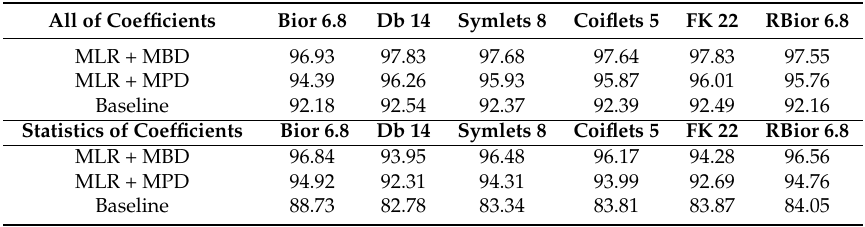
Table 17. Method performance in different feature spaces on